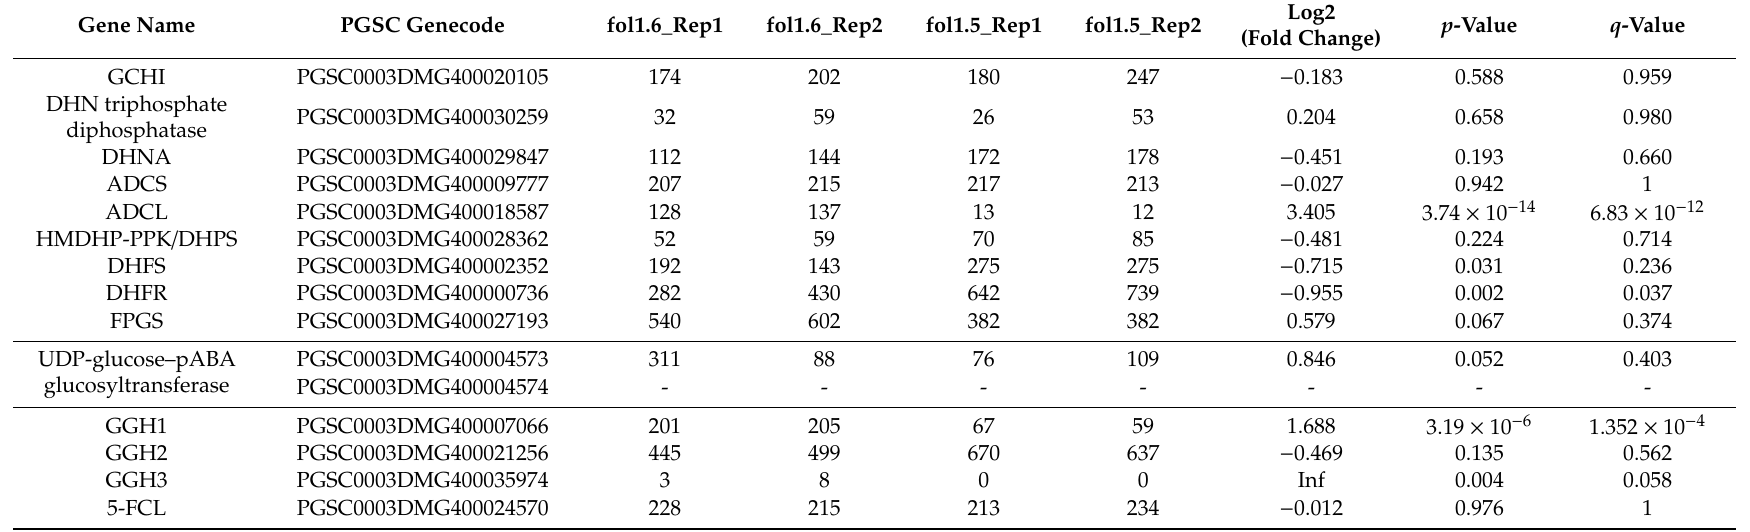
Table 2. Comparison of high and low fol lines (fol 1.6 vs. fol 1.5) based on RNA-Seq analysis. Genes involved in folate biosynthesis are listed with their corresponding PGSC IDs and pseudo counts for those genes as shown in two replicates for each individual. Fold change (log 2 ), p -values, and q -values are calculated for each comparison. In red are Log2 (fold change) > 1.5 or < − 1.5 AND p and q values < 0.05. GCHI, GTP cyclohydrolase I; DHN, dihydroneopterin; DHNA, DHN aldolase; ADCS, aminodeoxychorismate synthase; ADCL, aminodeoxychorismate lyase; HMDHP-PPK / DHPS, 6-Hydroxymethyldihydropterin pyrophosphokinase (HMDHP-PPK) / dihydropteroate synthase (DHPS); DHFS, dihydrofolate synthase; DHFR, dihydrofolate reductase; FPGS, folylpolyglutamate synthase; GGH, γ -glutamyl hydrolase; 5-FCL, 5-formyltetrahydrofolate cycloligase. The closest ortholog of the Arabidopsis UDP-glucose-pABA glucosyltransferase in potato was identified by phylogenetic analyses (Figure